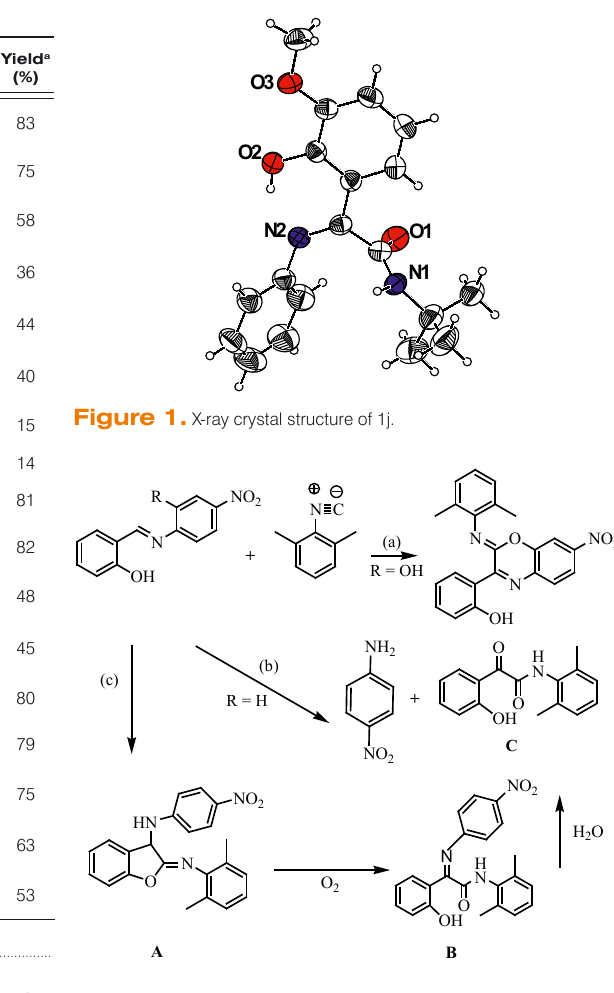
Scheme 3. Proposed mechanism for the formation of C.